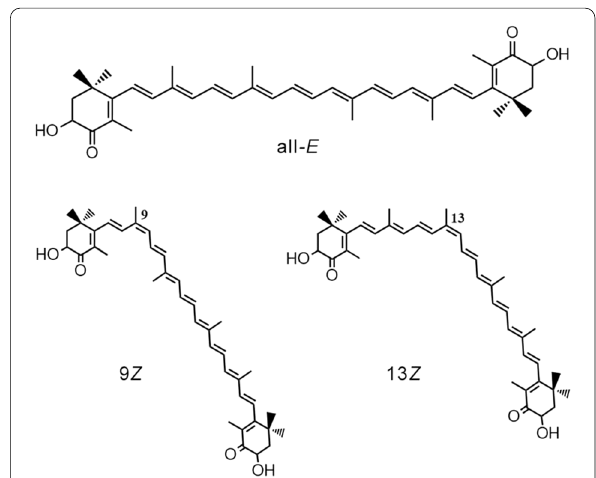
Fig. 1 Geometric isomers of